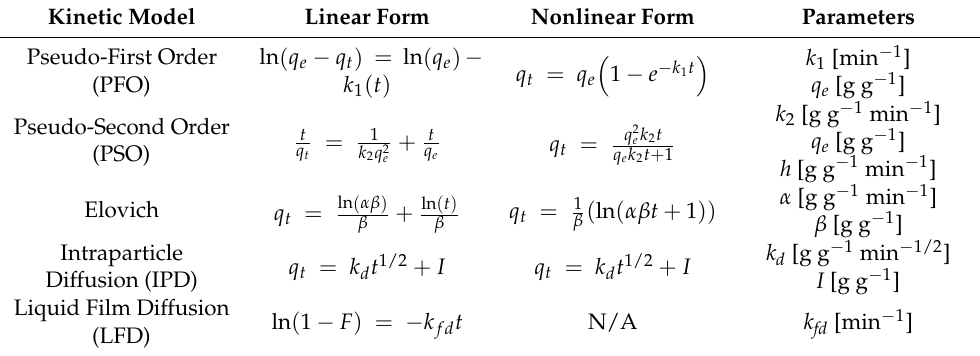
Table 2. Summary of linear and nonlinear equations of kinetic models and their parameters. Kinetic Model